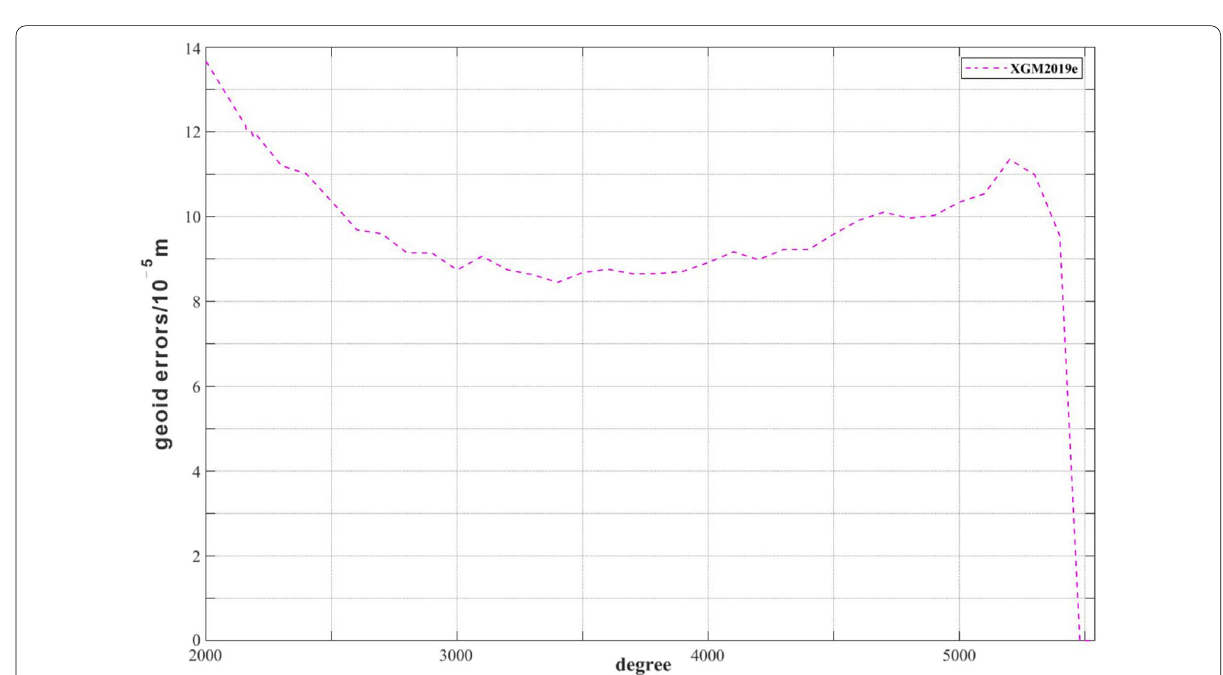
Fig. 5 Result of the geoid error degree